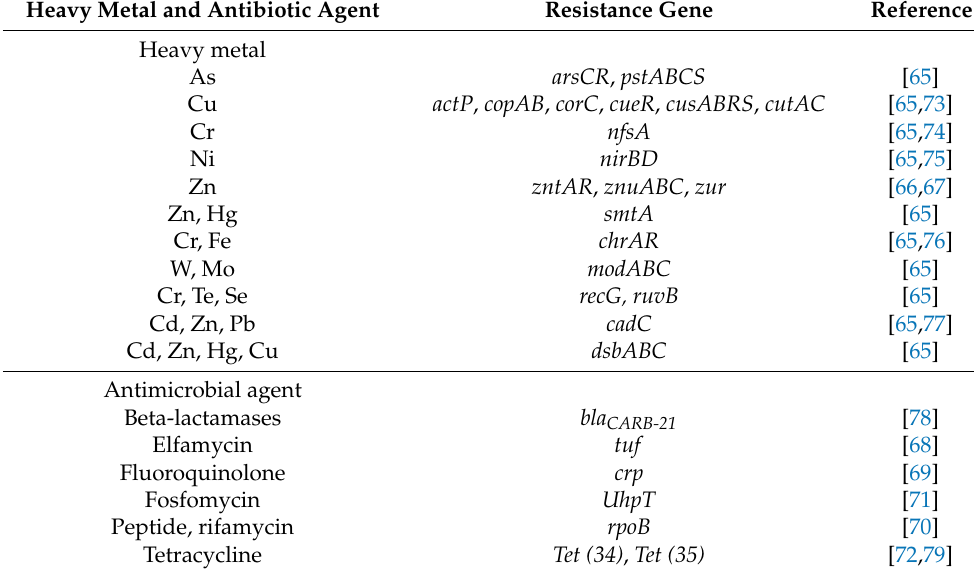
Table 2. The heavy metal and antibiotic resistance-related genes identified in the V. parahaemolyticus N10-18